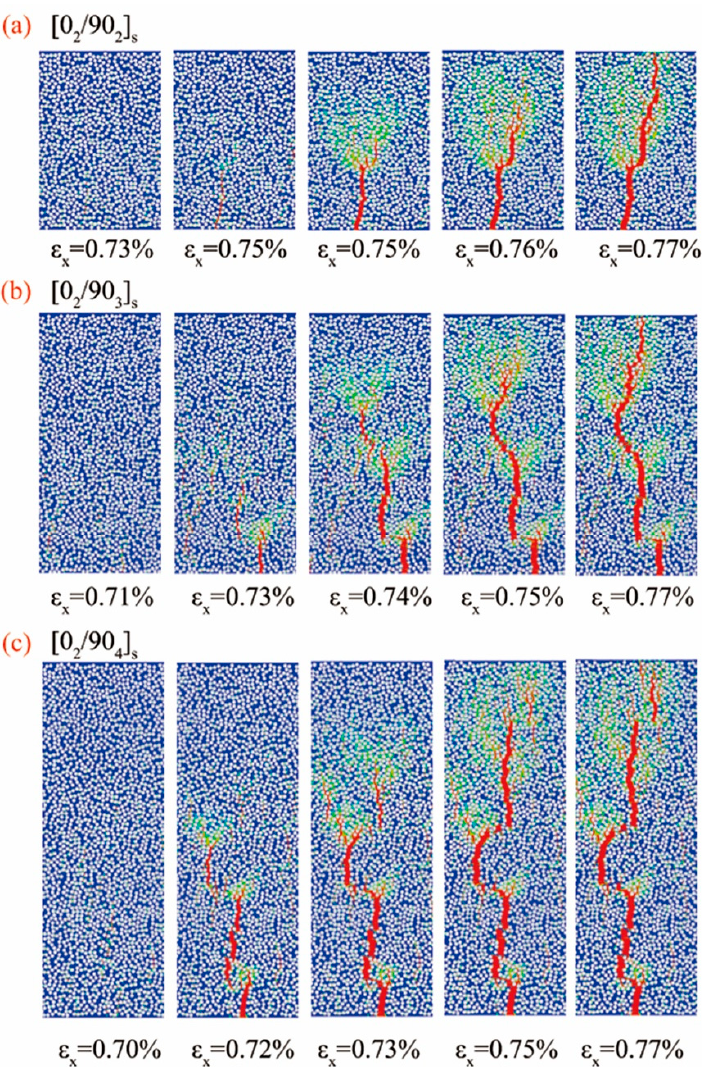
Figure 9. The simulation results of the development of the microcracks with the applied mechanical strain along x direction in the 90 ◦ plies of the cross-ply [0 2 / 90 n ] s (n = 2,3,4) laminate. ( a ) [0 2 / 90 2 ] s laminate; ( b ) [0 2 / 90 3 ] s laminate; ( c ) [0 2 / 90 4 ] s laminate.